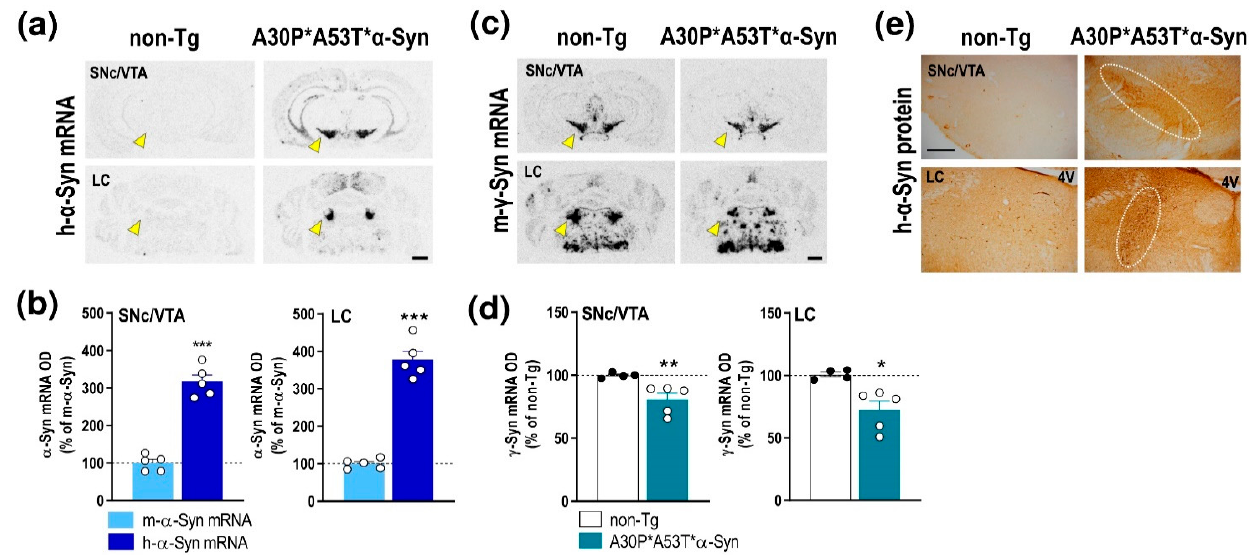
Figure 1. Profile of α -Syn expression in monoamine brain areas of A30P*A53T* α -Syn transgenic mice. ( a ) Coronal brain sections showing h- α -Syn mRNA levels in SNc/VTA assessed by in situ hybridization. Yellow arrowheads indicate the brain regions quantified in b. Scale bar: 1 mm. ( b ) Increased h- α -Syn mRNA expression in SNc/VTA and LC of A30P*A53T* α -Syn transgenic mice compared with m- α -Syn mRNA expression levels in the same mice ( n = 5 mice/group; *** p < 0.001 vs. m- α -Syn mRNA levels; Student’s t -test). ( c ) Coronal brain sections showing m- γ -Syn mRNA levels in SNc/VTA and LC assessed by in situ hybridization. Yellow arrowheads show the lower density of m- γ -Syn expression in A30P*A53T* α -Syn mice compared with non-Tg mice. Scale bar: 1 mm. ( d ) Reduced m- γ -Syn mRNA expression in SNc/VTA and LC of A30P*A53T* α -Syn transgenic mice compared with non-Tg mice ( n = 4–5 mice/group; * p < 0.05, ** p < 0.01 versus non-Tg mice; Student’s t -test). ( e ) Representative photomicrographs showing accumulated levels of h- α -Syn protein in SNc/VTA and LC of A30P*A53T* α -Syn transgenic mice. White frames indicate the SNc/VTA and LC brain regions. Scale bar: 200 µ m. For all figures, data represent the mean ± SEM. Abbreviations: SNc, substantia nigra compacta; VTA, ventral tegmental area; LC, locus coeruleus; 4V, 4-ventricle. See also Supplemental Figure